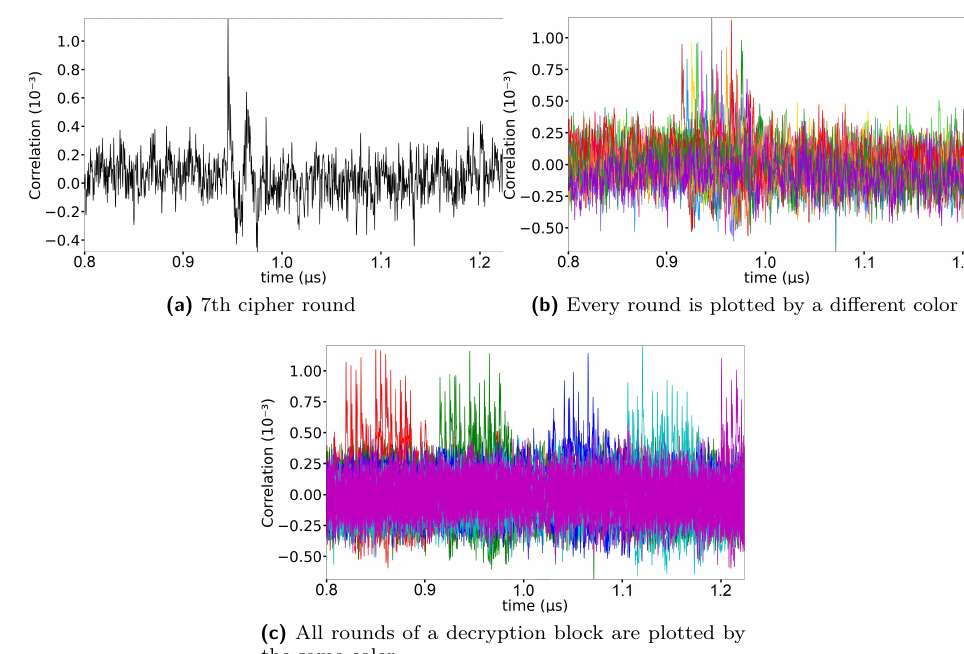
Figure 6: Multiple correlation traces associated to the selected HD power model, using 80,000,000